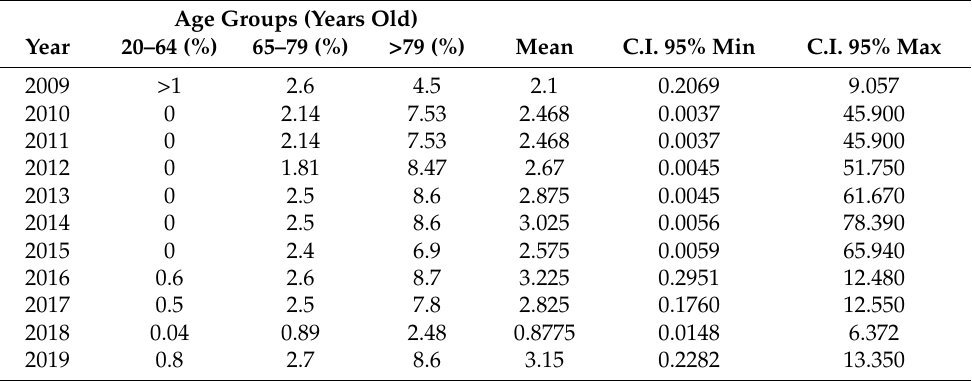
Table 3. Total edentulism in Mexico from 2009 to 2019 by age groups, according to SISVEPAB from the General Bureau of Epidemiology of the Ministry of